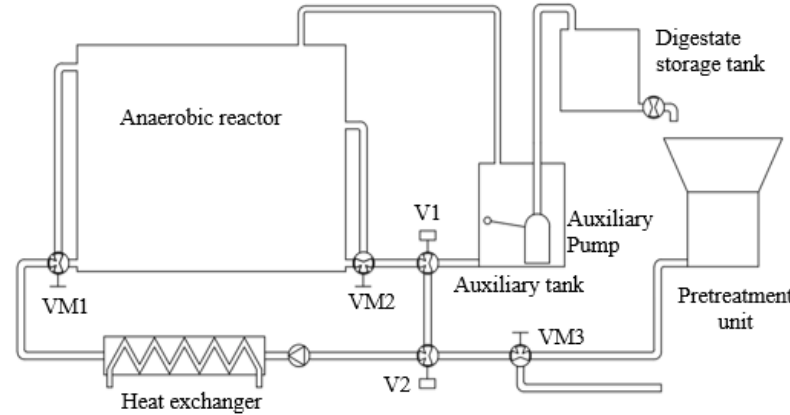
Figure 3. Description of components of the decentralized digestion plant and distribution of valve location and auxiliary equipment.